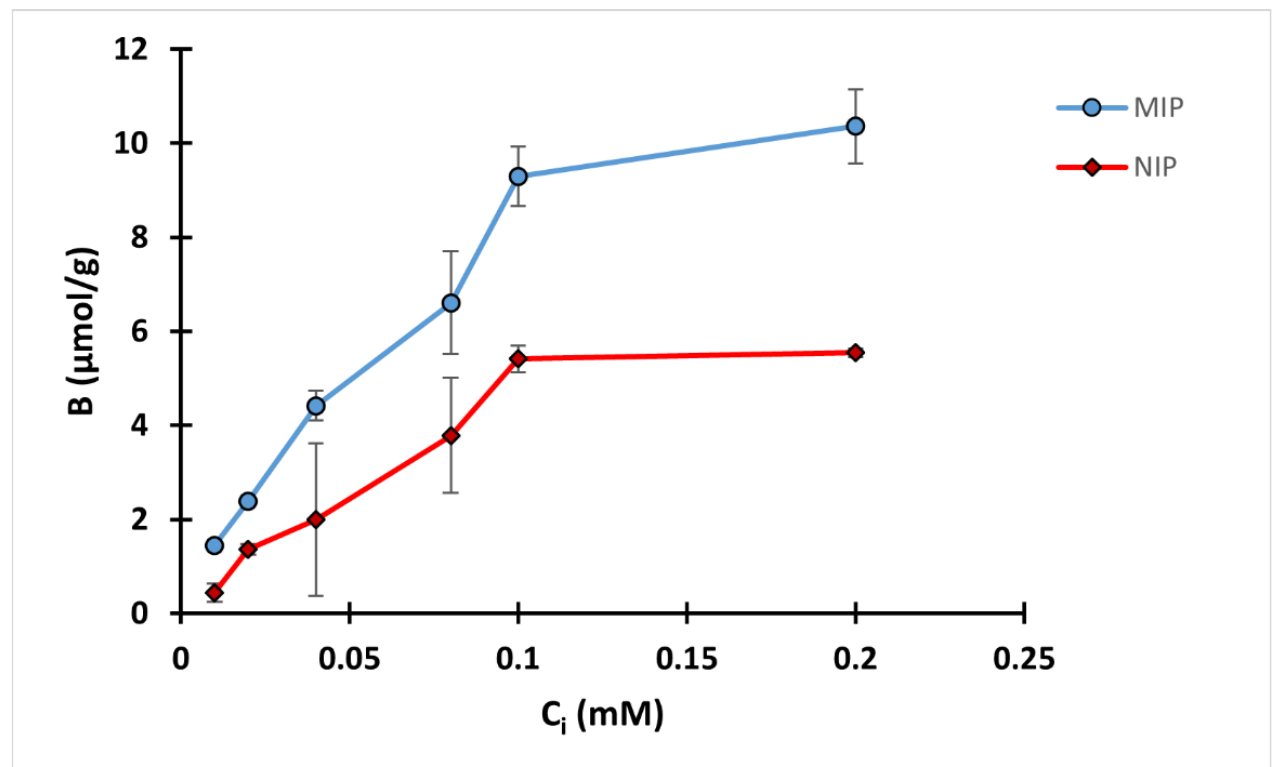
Figure 6. Binding isotherm of MIP C and NIP C.